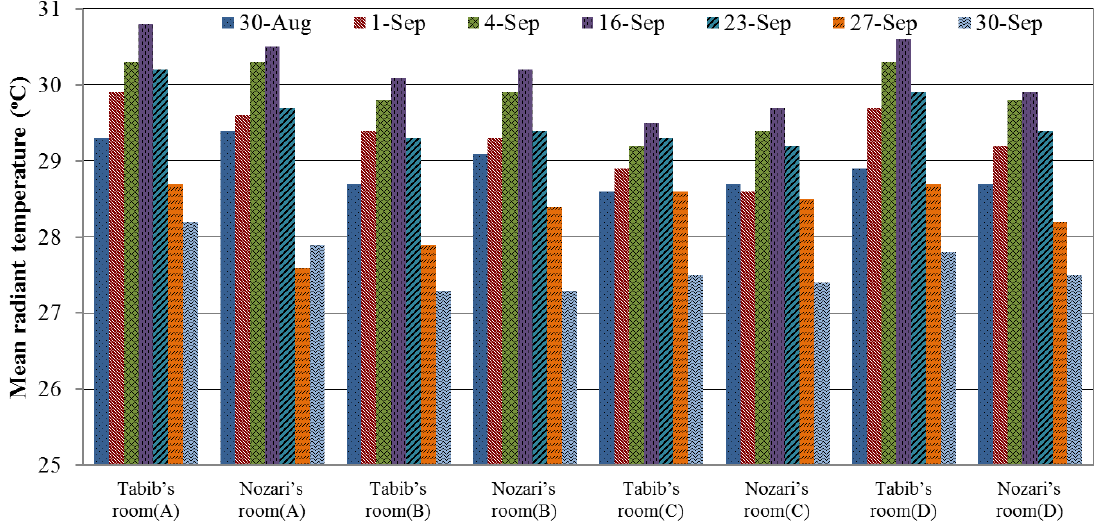
Figure 13. Mean Radiant Temperature (MRT) of rooms measured for different days in 2016.